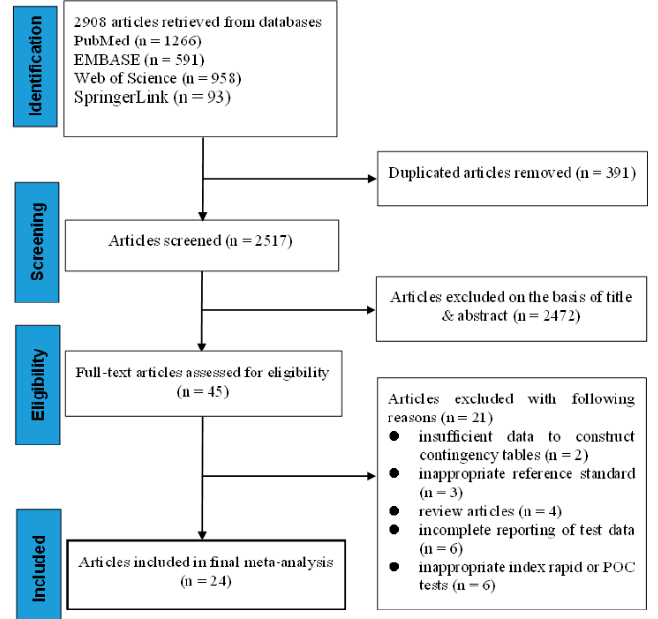
Figure 1. PRISMA flow diagram showing the number of records initially identified and that were subsequently excluded or included in the meta-analysis on the performance and operational characteristics of ICA- and NAIA-based POCTs for PEDV. PRISMA, preferred reporting items for systematic reviews and meta-analysis. Table 1. Characteristics of the studies included in the